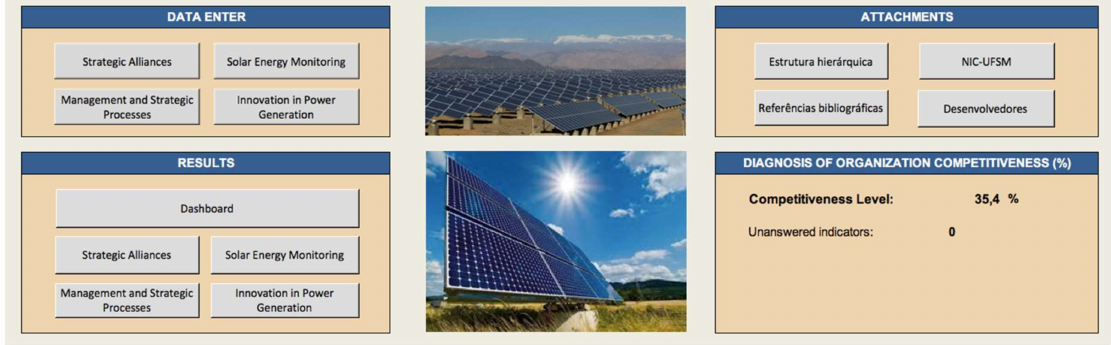
Figure 3. The initial screen of the developed tool with four blocks ( 1 ) Data Enter; ( 2 ) Results; ( 3 ) Attachments; and ( 4 ) Diagnosis of organizational